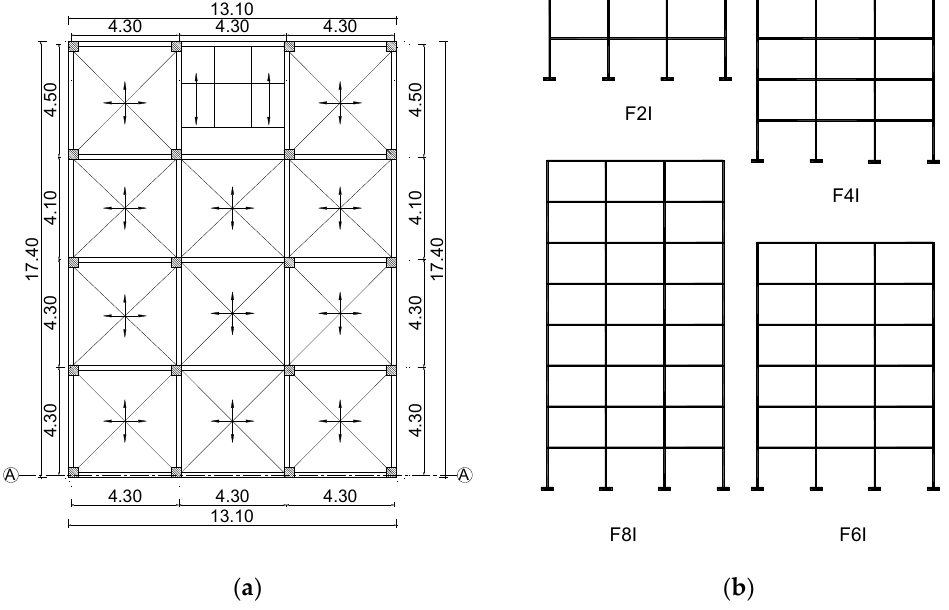
Figure 2. ( a ) Plan view of a typical storey of the considered buildings and ( b ) representation of the considered reference frames (frames of the A-axis in the plan view) (all dimensions are in m).